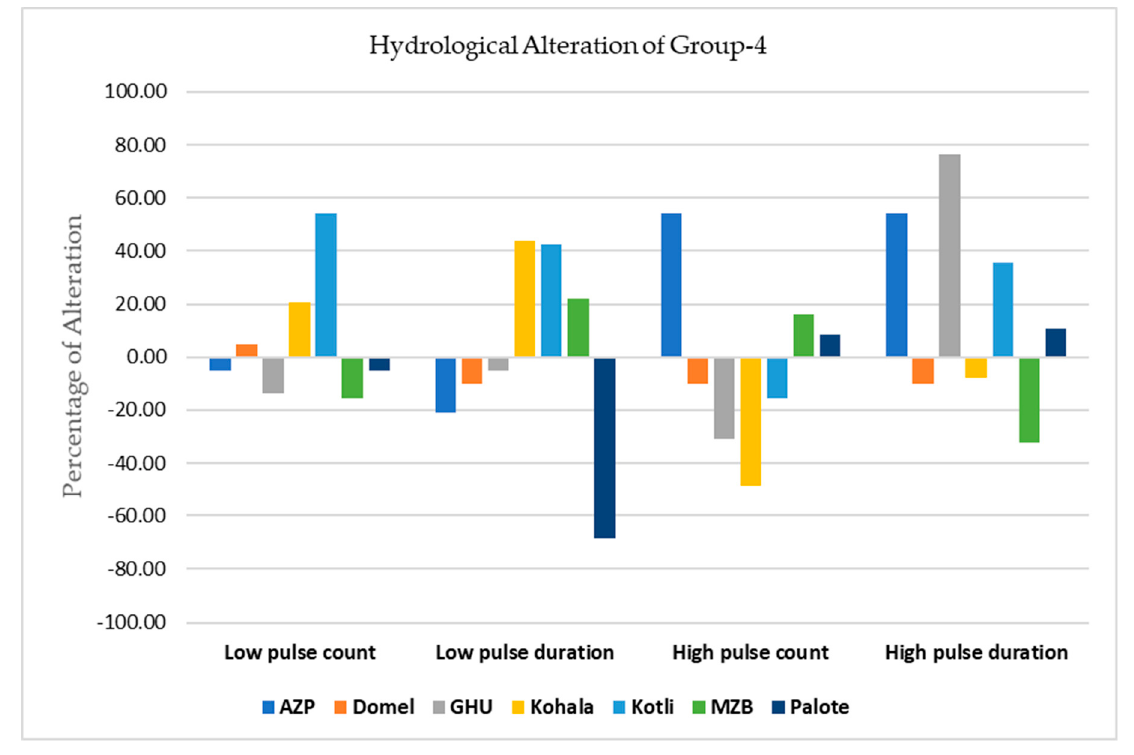
Figure 6. Hydrological Alteration of Group − 4 indicators.